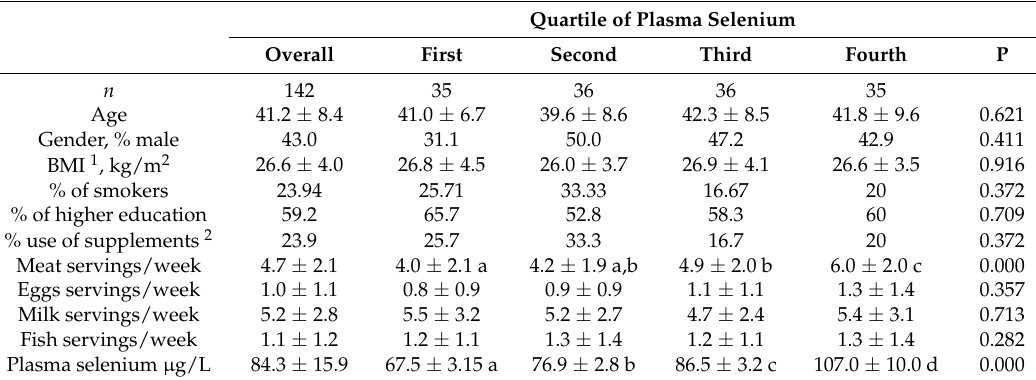
Table 1. Sample characteristics by quartiles of plasma selenium.